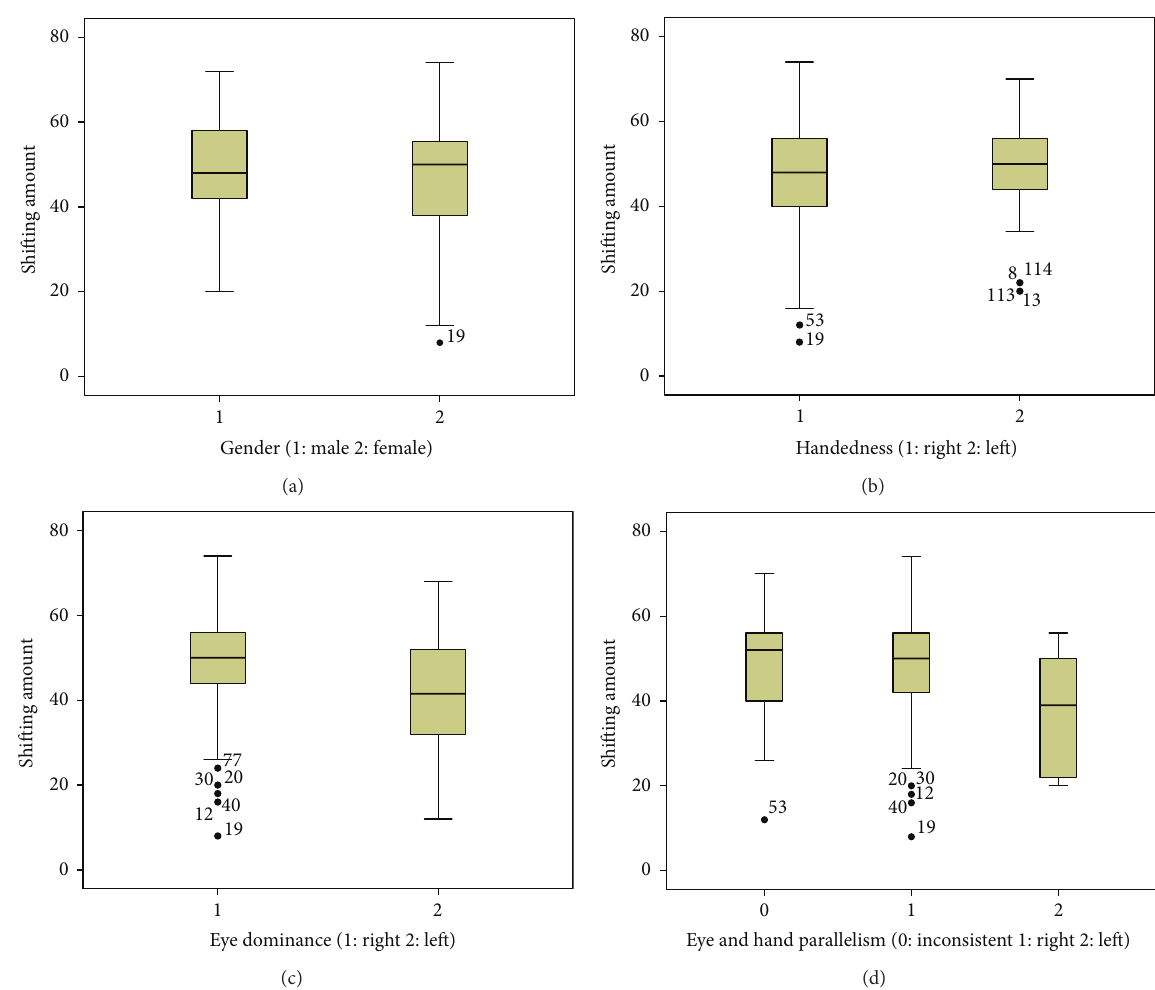
Figure 3: Box plots of shifting amount of far points in Miles test. (a) Gender, (b) handedness, (c) eye dominance, and (d) eye and hand parallelism. Right eye dominant subjects showed greater amount of shifting in Miles test.